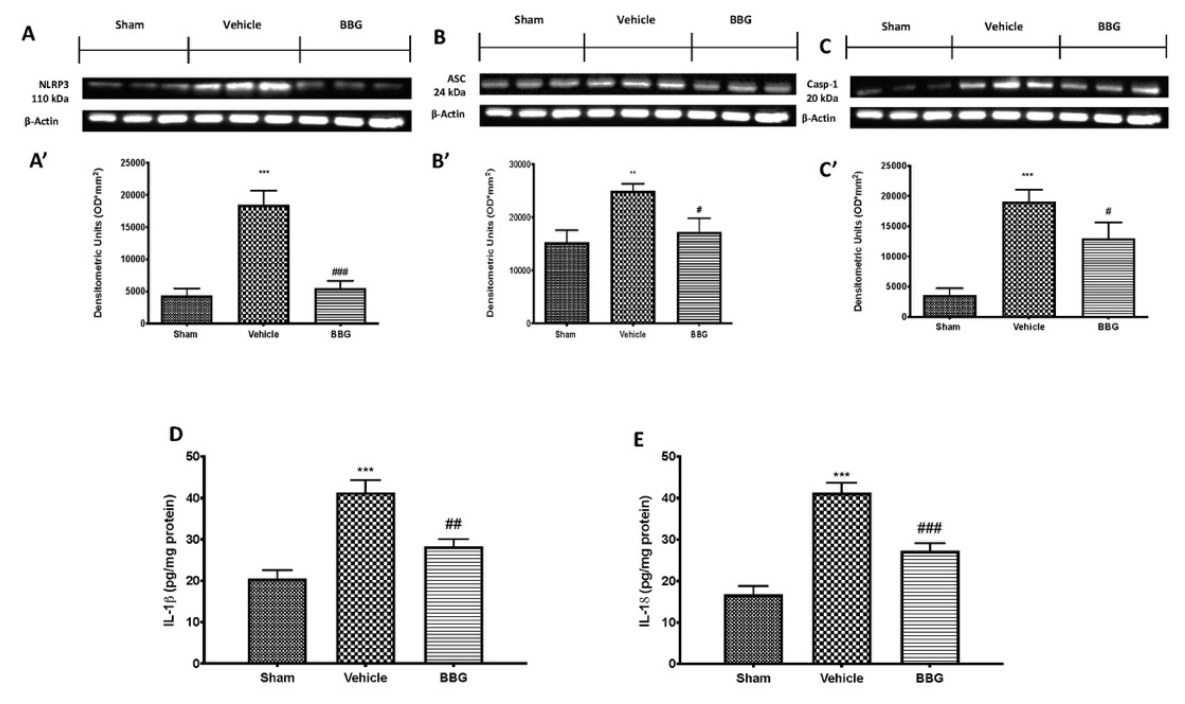
Figure 4. Western blot and respective quantification of NLRP3 ( A , A’ ), ASC ( B , B’ ) and Casp-1 ( C , C’ ) in brain tissue. Cytokines expression: IL-1 β ( D ) and IL-18 ( E ). Data are representative of at least three independent experiments and are expressed as mean ± SEM from N = 6 rats/group. ** p < 0.01 vs. sham; *** p < 0.001 vs. sham; # p < 0.05 vs. vehicle; ## p < 0.01 vs. vehicle; ### p < 0.001 vs. vehicle.